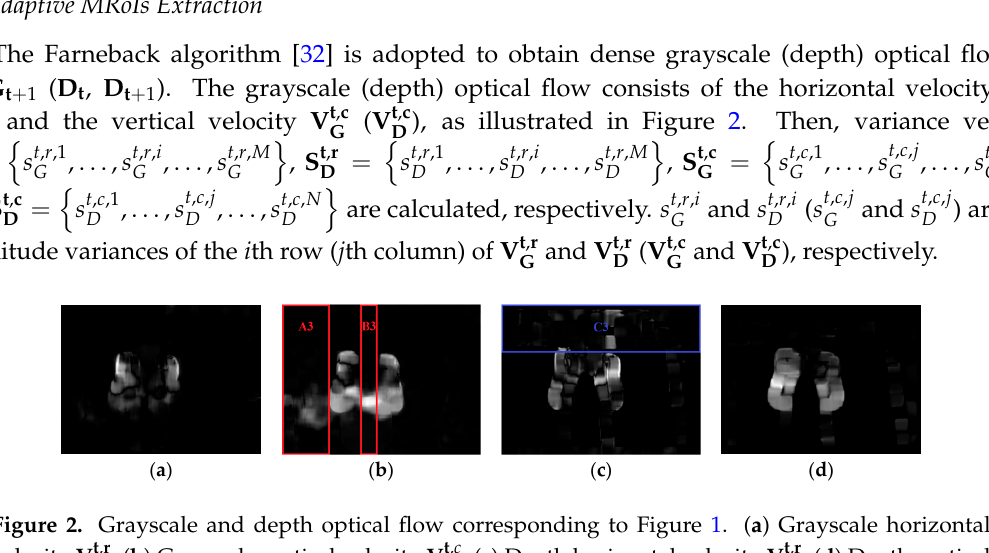
; ( c ) Depth horizontal velocity V t , r G